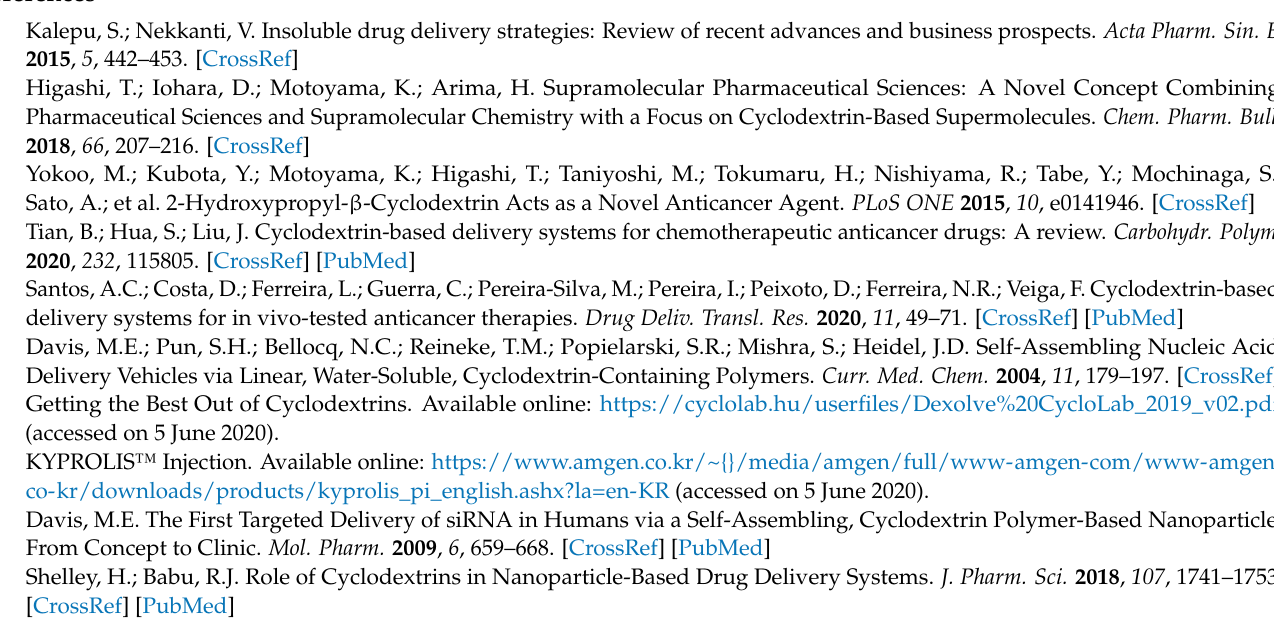
the CD:CC molar ratio in HeLa cells; Figure S14: Example for cell counting; Figure S15: Impact of Figure S16: Development of cytoplasmic vacuolization in HeLa cells; Figure S17: HeLa cell